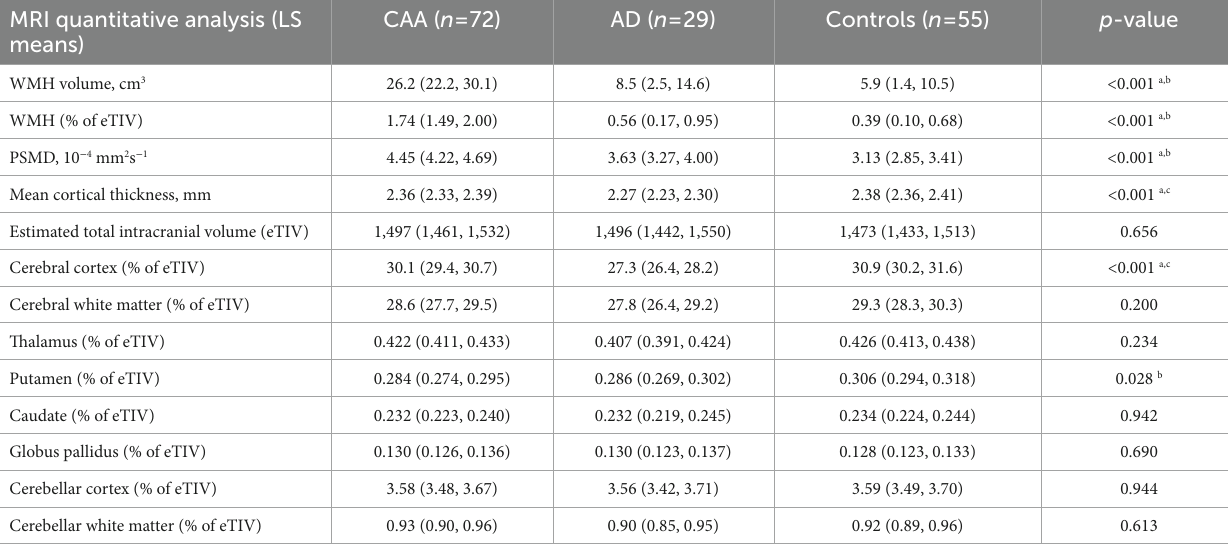
TABLE 4 Summary of quantitative MRI markers (least square means) using only the Calgary data. MRI quantitative analysis (LS